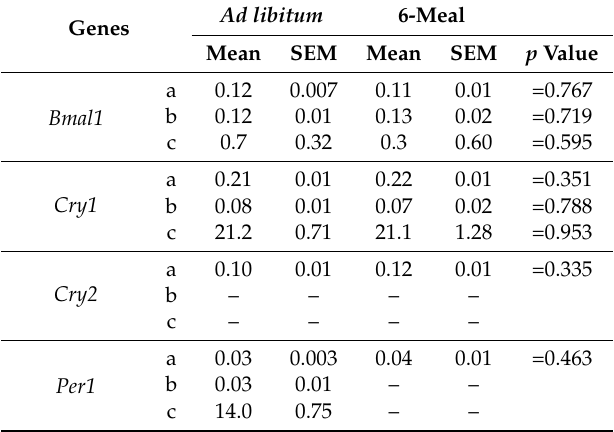
Table 2. t -Test analysis on cosinor parameters for clock and metabolic genes in the